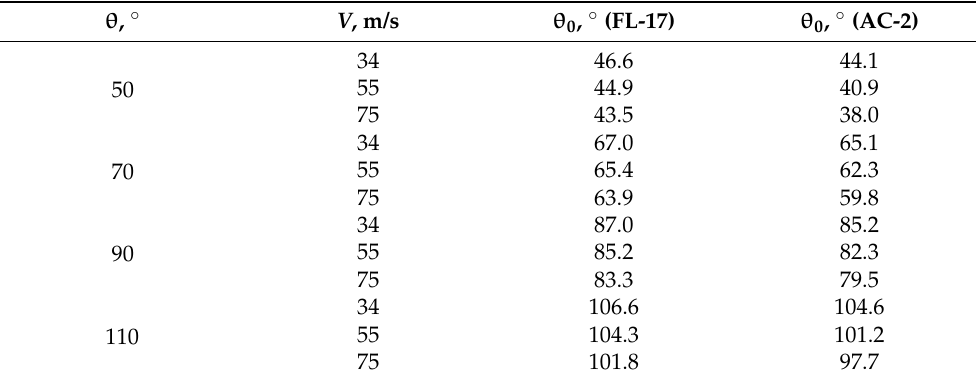
Table 2. Amiet’s angle correction for plane shear layer (FL-17 CARDC) and cylindrical shear layer (AC-2